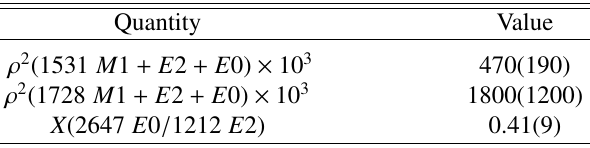
Figure 3. Gamma-ray (a), conversion-electron (b), and electron- positron pair (c) energy spectra collected using the Super-e pair spectrometer for 52 Cr. Table 1. E 0 Transition strengths and related quantities